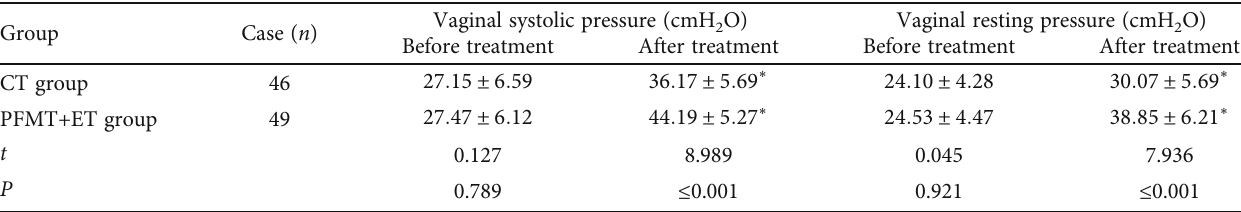
Table 2: Comparison of pelvic fl oor muscle tension between the two